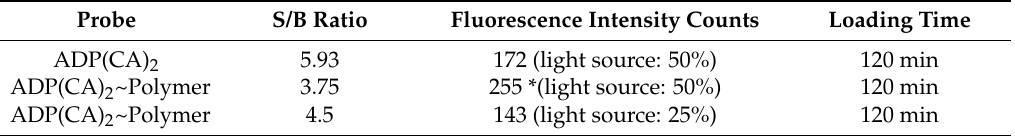
Table 1. The comparison between ADP(CA) 2 and ADP(CA) 2 ~Polymer conjugate.